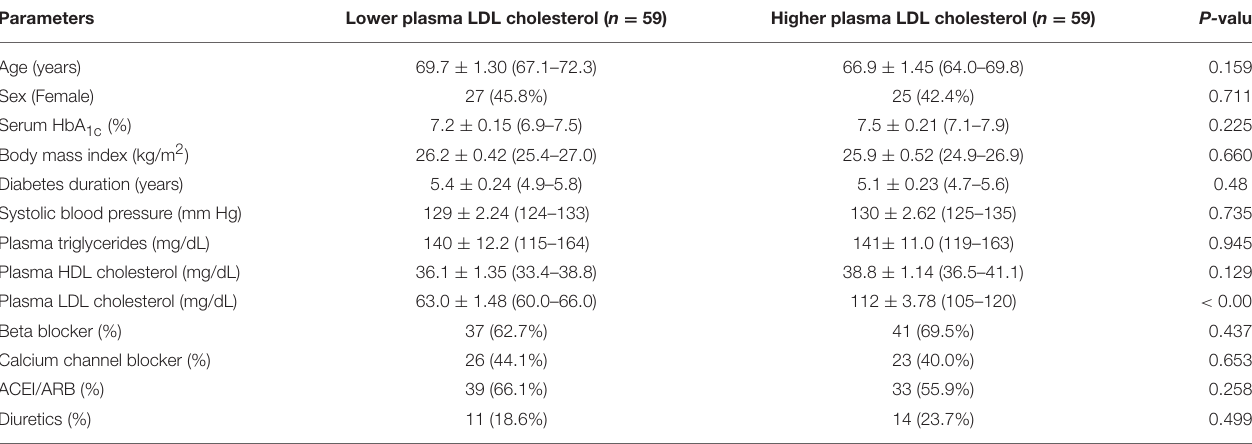
TABLE 1 | Demographic features of the participants.